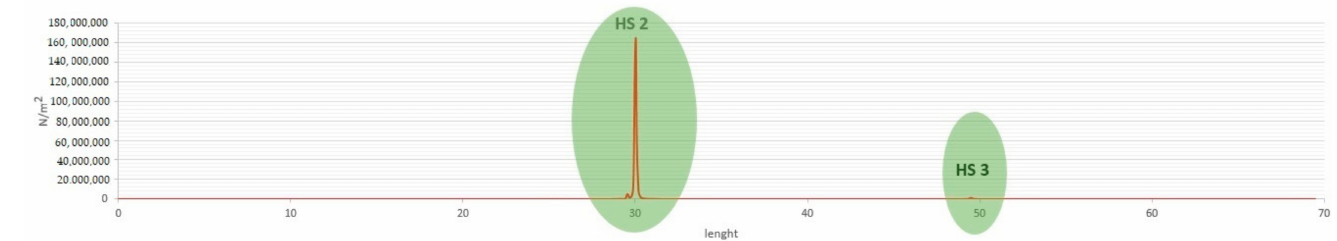
Figure 9. Shear stress variation on longitudinal profile.